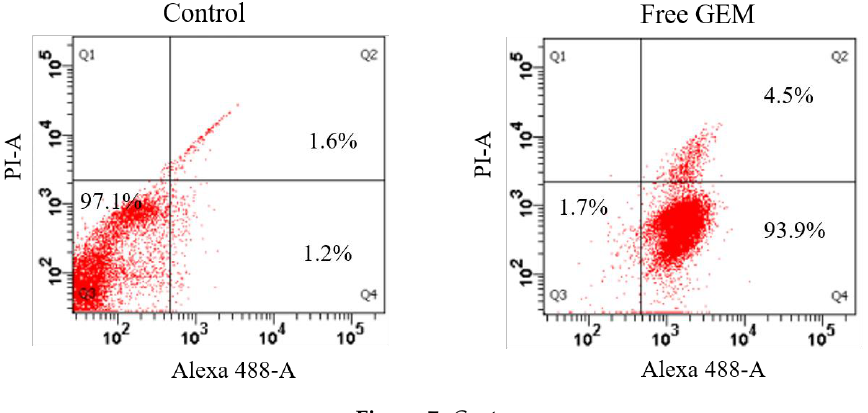
Figure 7. FACS analysis of apoptosis in HeLa cells treated with PBS as a control, free GEM, biotin + PG4.5-DETA-biotin/GEM, or PG4.5-DETA-biotin/GEM for 24 h followed by Annexin V-Alexa Fluor 488 and PI double staining. 4. Conclusions In the present study, the PAMAM dendrimer was modified with DETA followed by conjugation to biotin through the amide bond via EDC/NHS chemistry to develop an active biotin-targeted drug nanocarrier. Our 1 H NMR, FTIR, and Raman spectroscopy analysis confirmed the coupling of DETA and biotin to the dendrimer. Gemcitabine was loaded to form PG4.5-DETA-biotin/GEM nanoparticles, which exhibited a spherical shape with a diameter of 81.60 ± 6.08 nm and 0.47 ± 1.25 mV surface charge. The drug-loading content and encapsulation efficiency were 10.84 ± 1.06% and 47.01 ± 0.71%, respectively. Flow cytometry and fluorescent microscopy demonstrated the PG4.5- DETA-biotin/GEM nanoparticles exhibited high cellular uptake efficiency, indicating the nanoparticles precisely targeted the cancer cells and were taken up via SMVT mediated endocytosis. The in vitro cytotoxicity assays revealed that PG4.5-DETA-biotin was non-toxic whereas PG4.5- DETA-biotin/GEM nanoparticles exerted high cytotoxicity and anti-proliferative activity in HeLa cells. Furthermore, double staining and FACS analysis proved PG4.5-DETA-biotin/GEM nanoparticles induced significant apoptosis. Based on these results, we conclude that PG4.5-DETA- biotin nanoparticles could represent a potential vitamin-targeted nanocarrier system for tumor- specific biotin-targeted delivery of anticancer drugs. Further studies are in progress to develop these nanoparticles as an in vivo delivery system. Supplementary Materials: The following are available online at www.mdpi.com/xxx/s1, Figure S1: UV- Visible spectrophotometer study of gemcitabine. A) The absorbance of free gemcitabine at different concentration and B) The standard curve of free gemcitabine in PBS. Figure S2: UV- Visible spectrophotometer study of FITC. A)